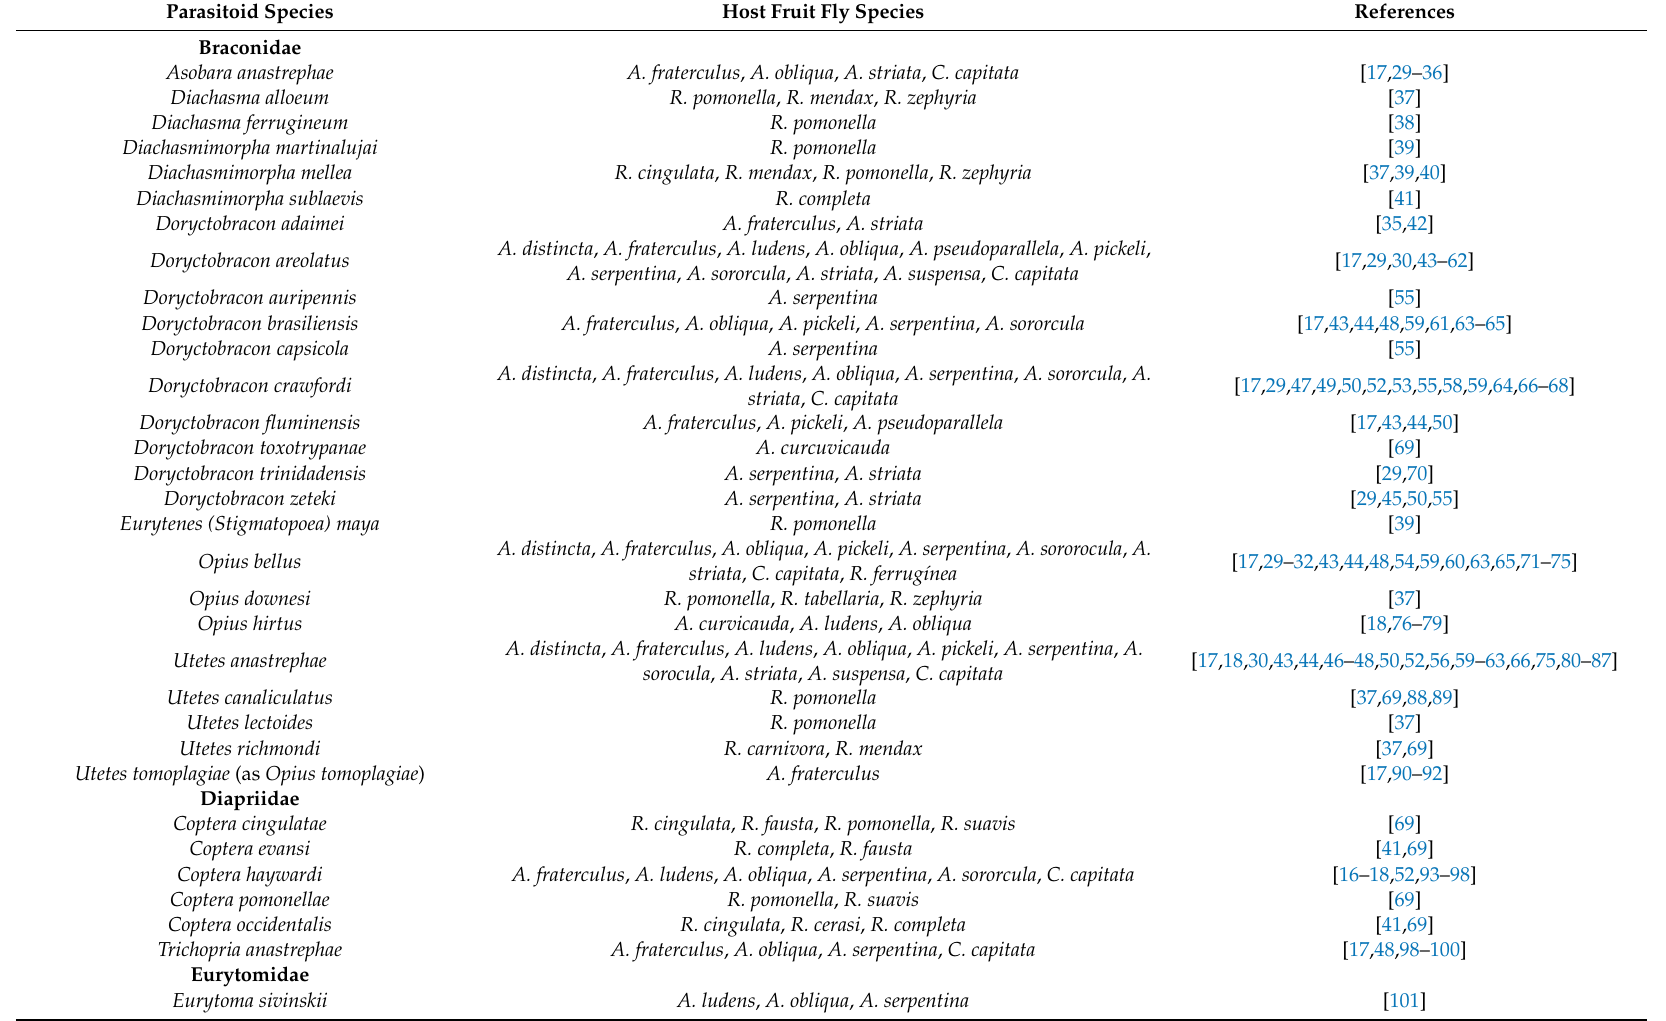
Table 2. Native parasitoid species and their fruit fly hosts in the